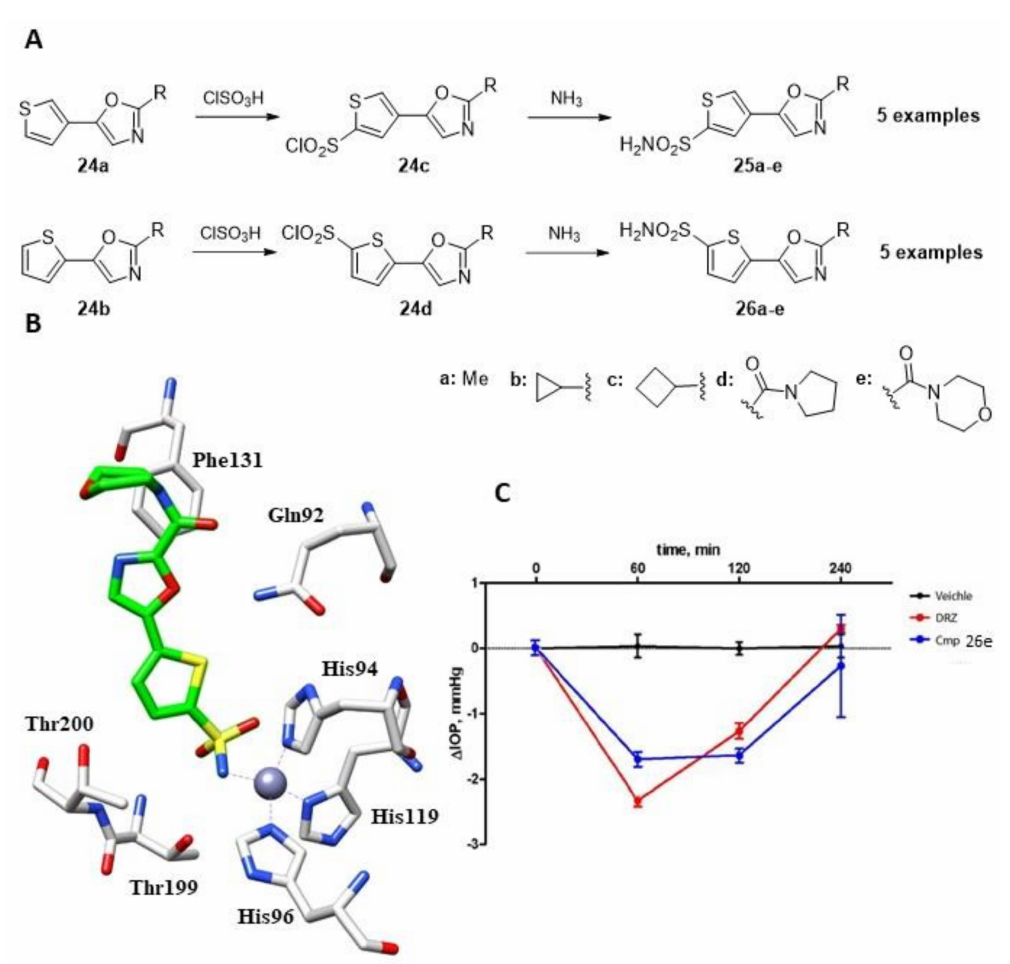
Figure 4. ( A ). Schematic synthesis of thiophene sulfonamides by Krasavin et al. ( B ). Binding mode of compound 26e within the active site of hCA II (PDB: 5NEE). ( C ). The drop in intraocular pressure ( ∆ IOP, mmHg) versus time (min) in hypertonic saline-induced ocular hypertension in rabbits, treated with 50 µ L of 1% solution of compounds 26e using 2% dorzolamide ( DRZ ) solution as a reference drug and vehicle